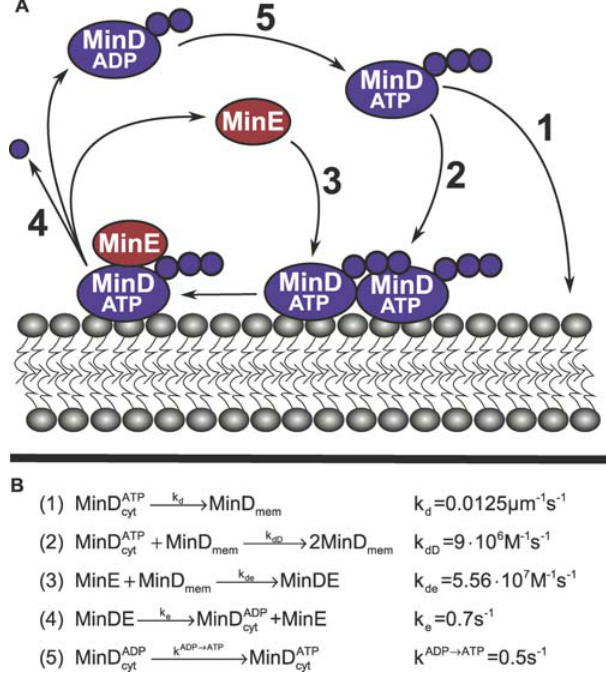
Figure 2. Cartoon of the Min System and the Corresponding Reaction Scheme and Rate Constants (A) Shows the Min system and (B) shows the corresponding reaction scheme and rate constants. The reaction scheme is essentially adapted from Huang et al. [30]. The diffusion constant for proteins in the cytoplasm is 2.5 3 10 (cid:1) 8 cm 2 s (cid:1) 1 and in the membrane, 1 3 10 (cid:1) 10 cm 2 s (cid:1) 1 . In the PE (cid:1) mutant: k d ¼ 1.25 3 10 (cid:1) 6 l ms (cid:1) 1 and the membrane diffusion is 1 3 10 (cid:1) 12 cm 2 s (cid:1) 1 . DOI: